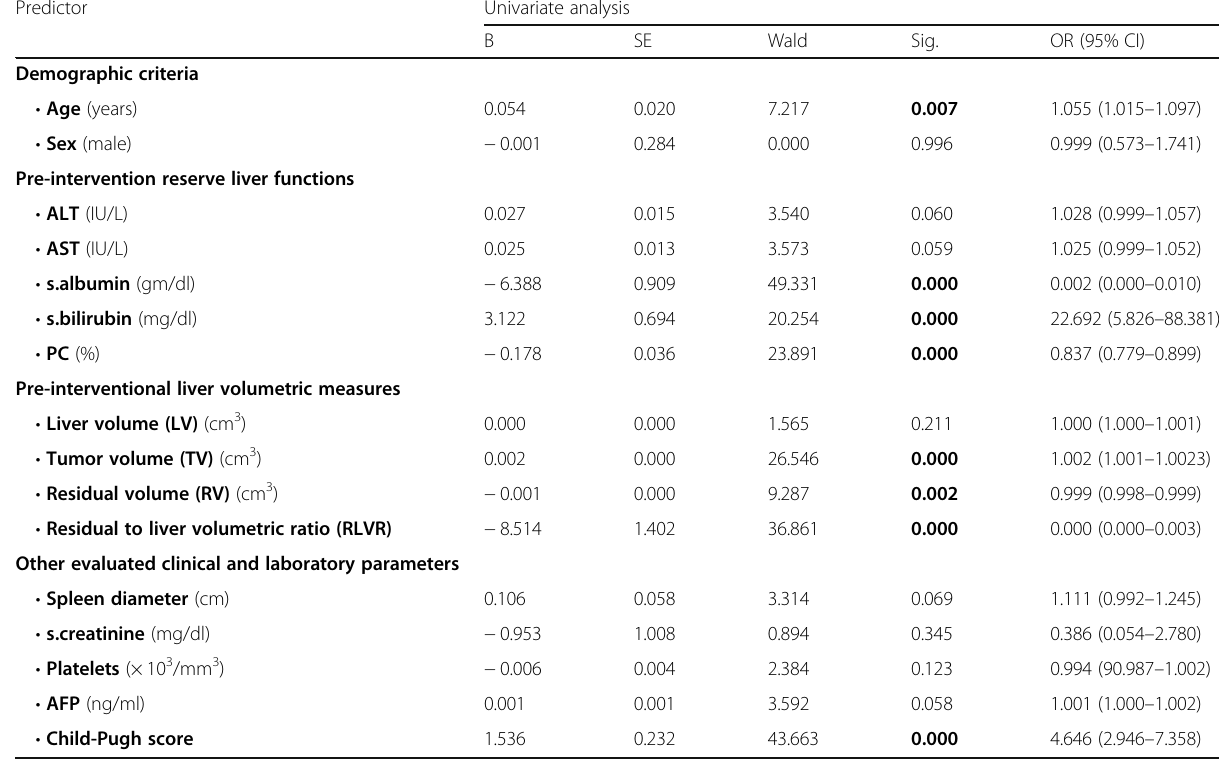
Table 2 Logistic regression analysis for the proposed predictors of liver decompensation Predictor Univariate analysis B SE Wald Sig.